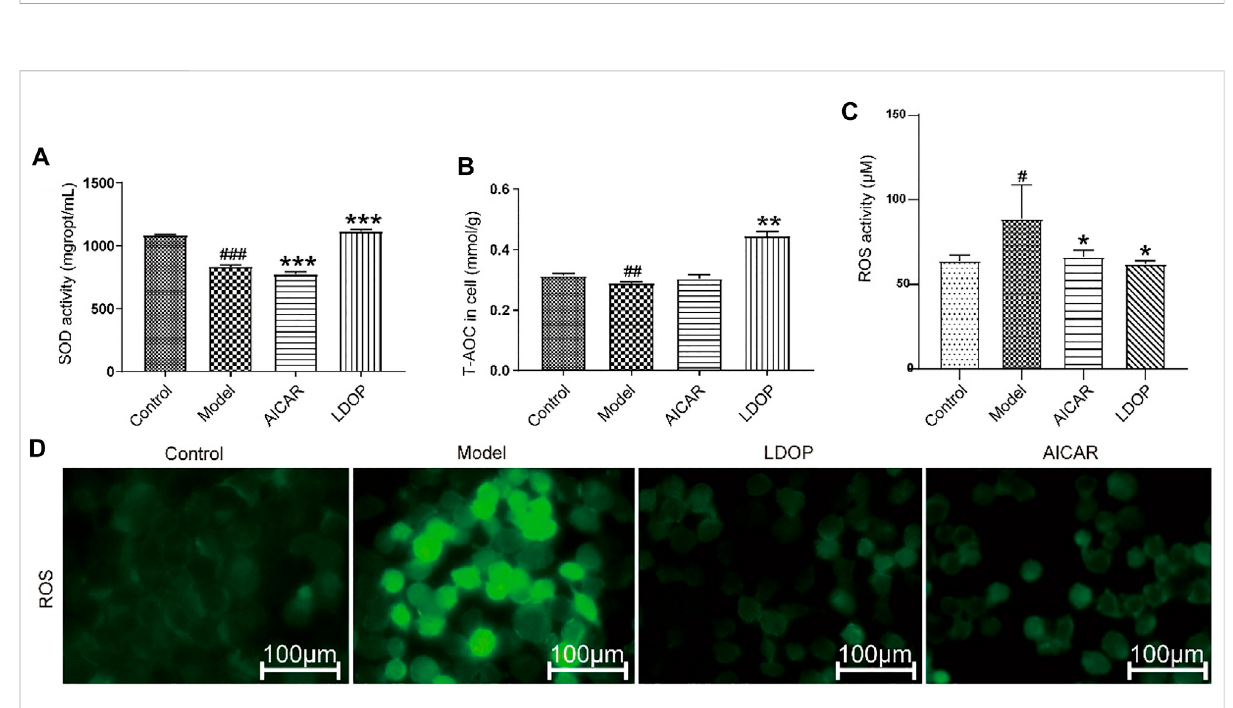
FIGURE 8 Effects of LDOP-1 on the production of SOD, T-AOC and ROS. (A – C) The levels of SOD, T-AOC and ROS were measured using a biochemical markerskit.TheexpressionofROSwasdetectedbyImmuno fl uorescencetechnique (D) .Dataareexpressedasthemean±SDofthreeindependent experiments.# p < 0.05, ## p < 0.01, ### p < 0.001 comparethecontrol group; * p < 0.05 and** p < 0.01,*** p < 0.001 compare modelgroup. LDOP stood for